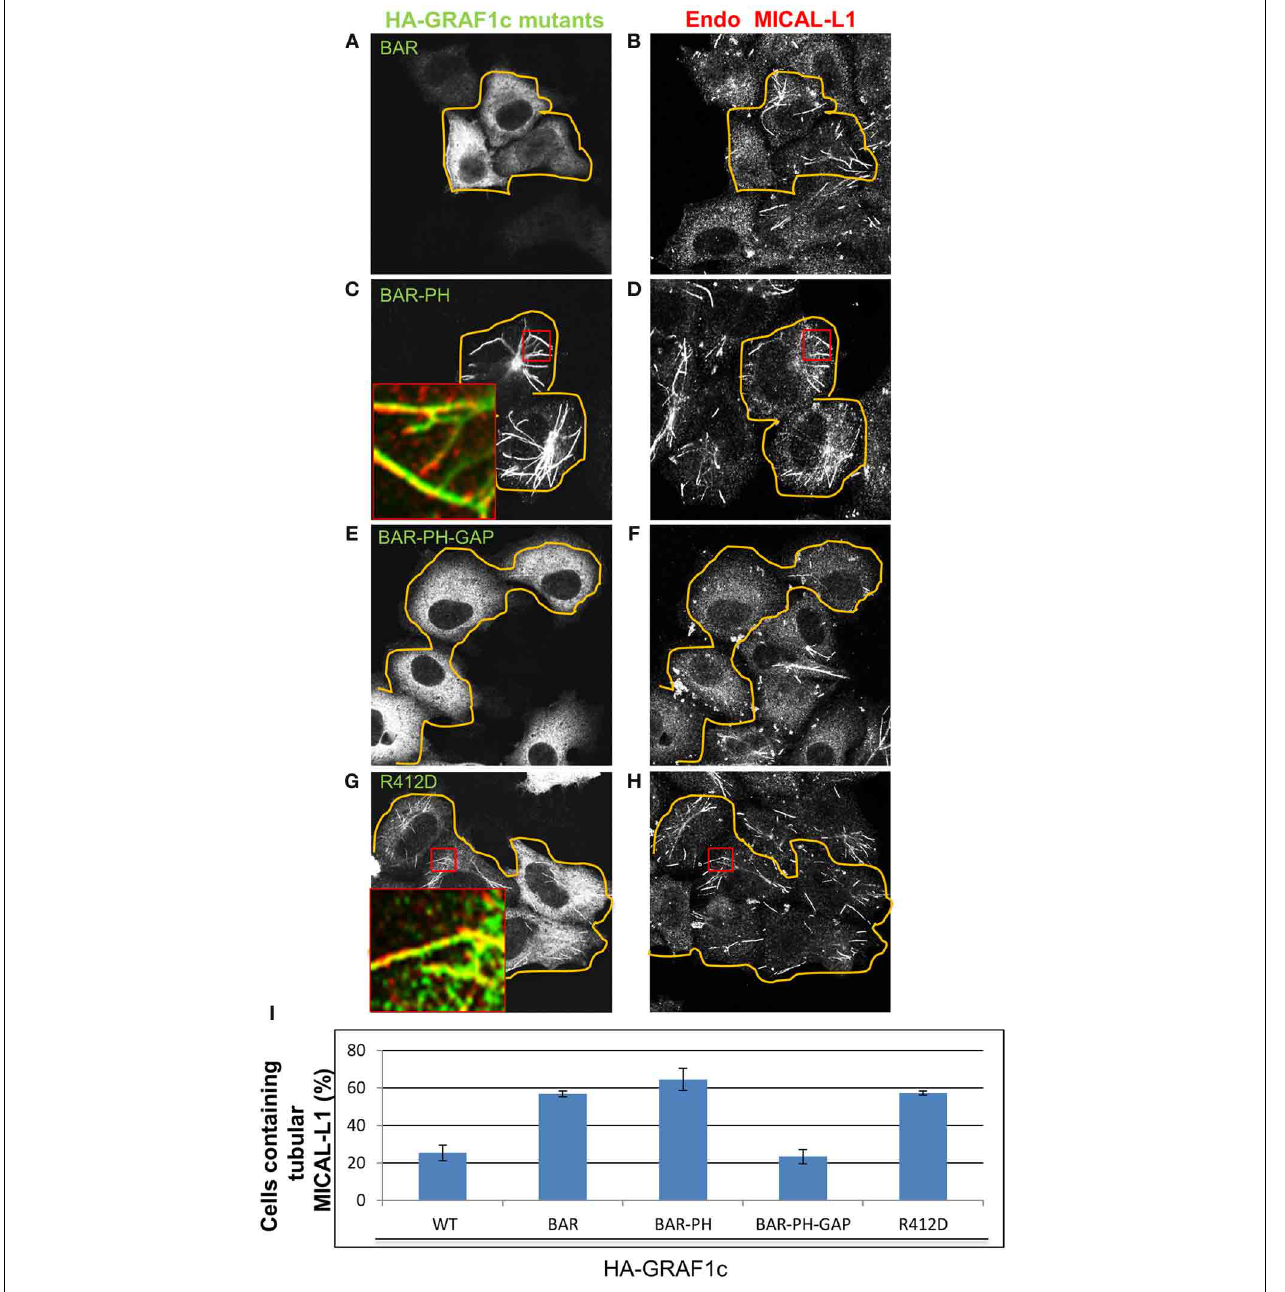
FIGURE 6 | TheGAPdomainofGRAF1cisrequiredtopromotevesiculation ofMICAL-L1-containingtubularendosomes. Cellsgrownoncoverslipswere eithertransfectedwith (A,B) theHA-GRAF1cBARdomain(orangelinesindicate the transfected cells), (C,D) the HA-GRAF1c BAR-PH domains, (E,F) the HA-GRAF1c BAR-PH-GAP domains, or (G,H) the mutant HA-GRAF1c (R412D)